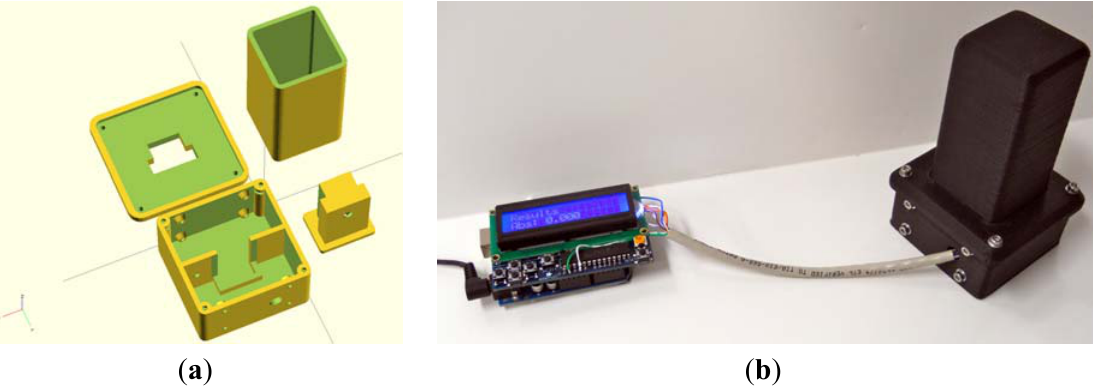
Figure 1. The open-source colorimeter: ( a ) schematic of case design in OpenSCAD, and ( b) the assembled case with